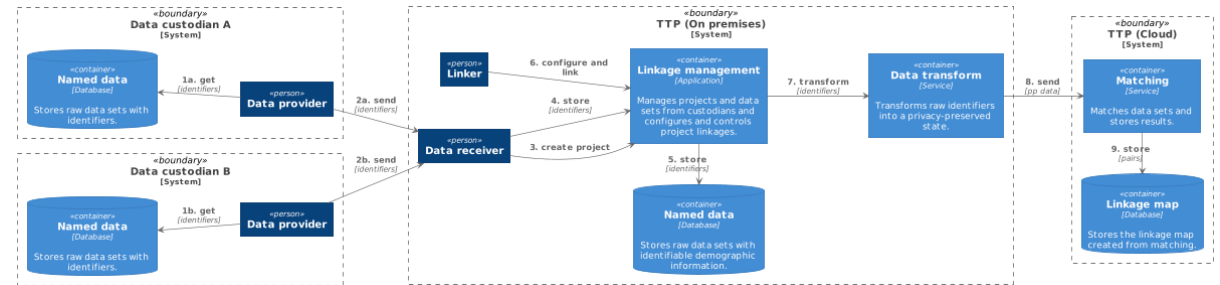
Figure 2. Hybrid cloud trusted third party model. PP: privacy-preserved; TTP: trusted third party.